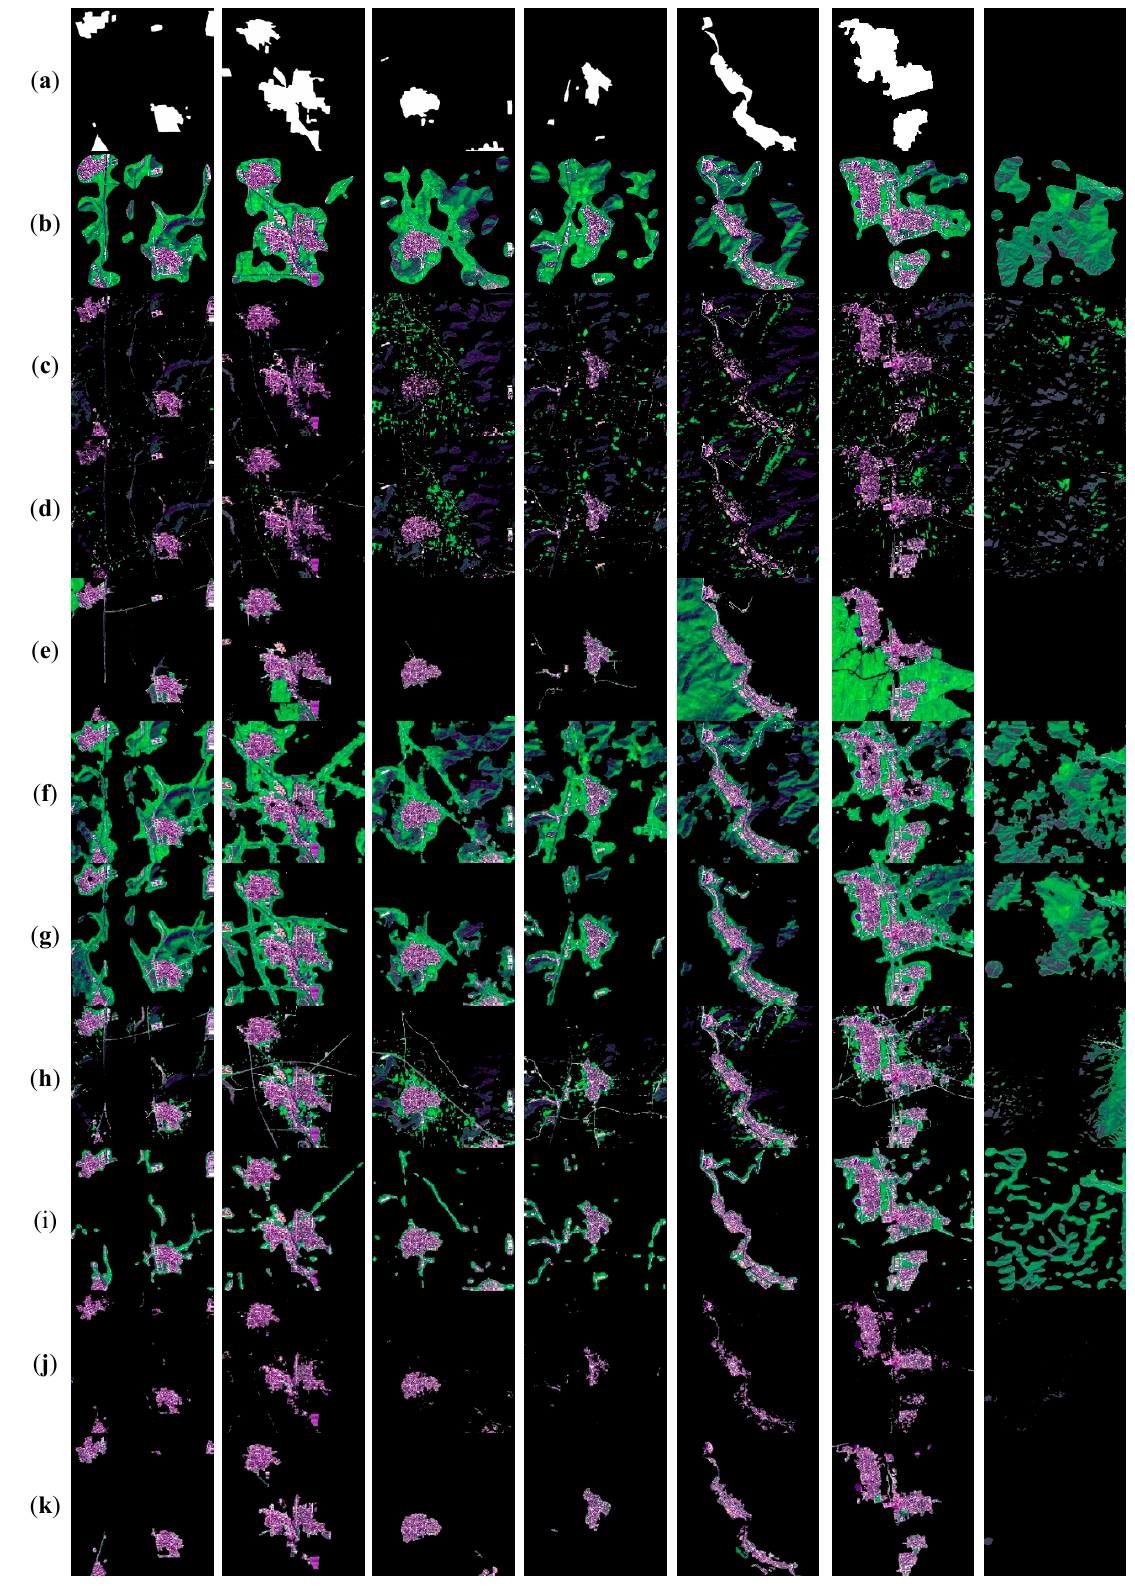
Figure 11. Visual comparison of ROIs from Group SPOT5 - Residential area . From top to bottom are ( a ) manual ground truth masks; ( b ) ITTI; ( c ) FT; ( d ) MSSS; ( e ) CB; ( f ) SIM; ( g ) CA; ( h ) TMM; ( i ) FDA-SRD; ( j ) JMS; and ( k ) EP-JMS.